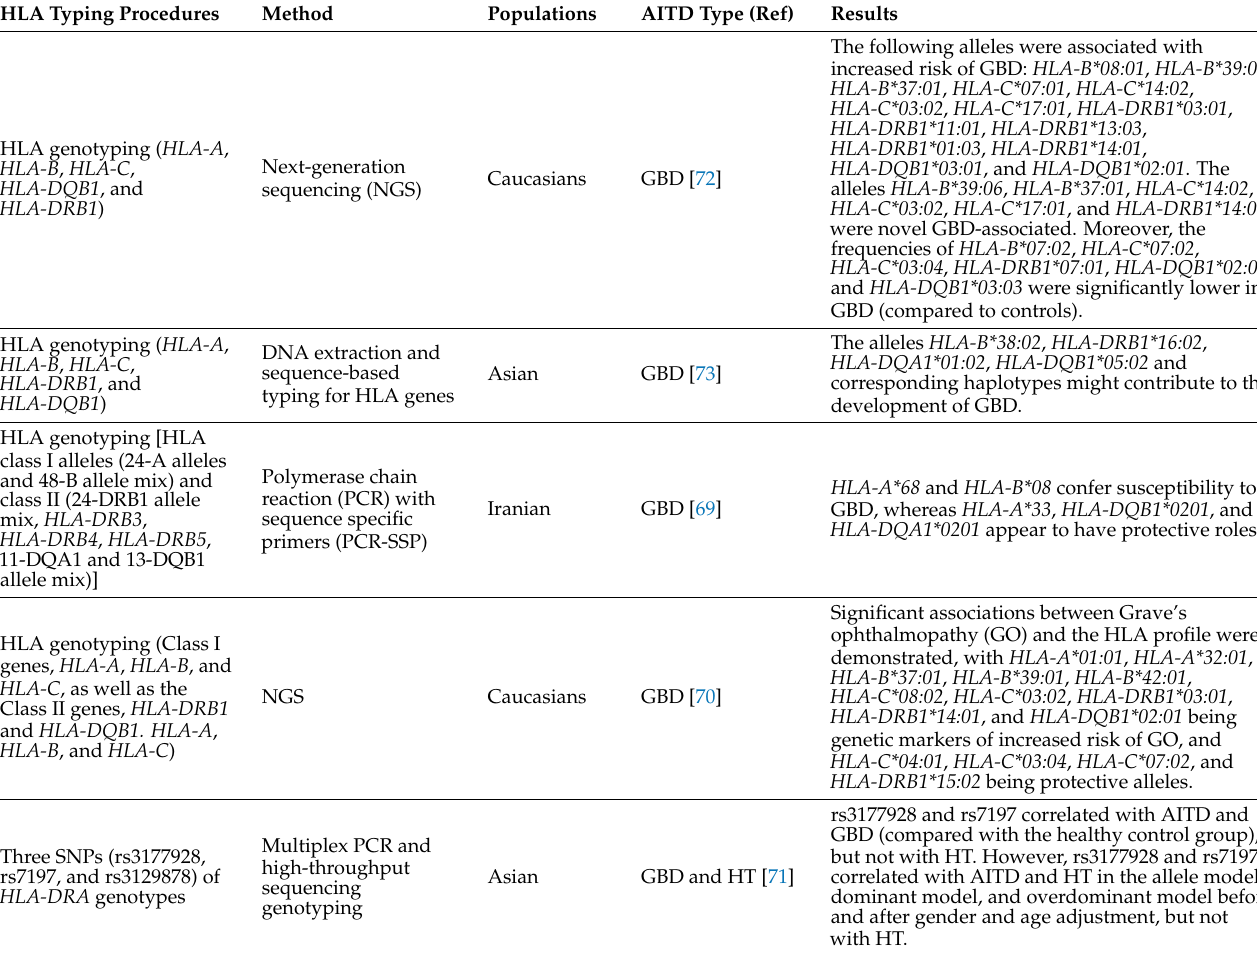
Table 2. Recent studies on SNPs and HLA alleles in individuals with